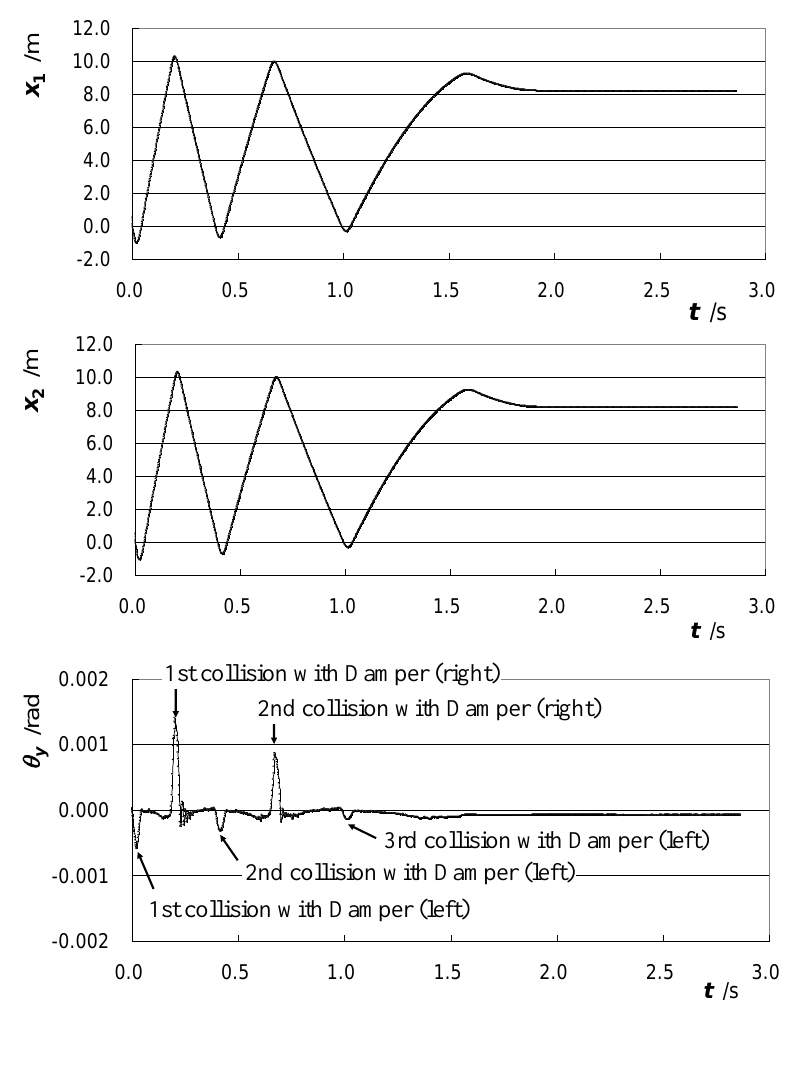
Figure 4. Change in positions at CC1 and CC2 and in pitching